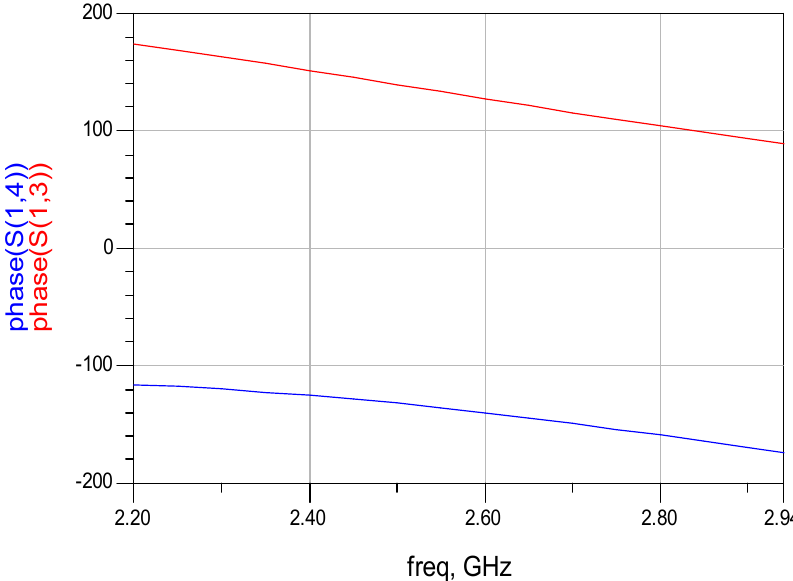
Figure 7. The branch line coupler phase difference between S13 and S14 parameters.